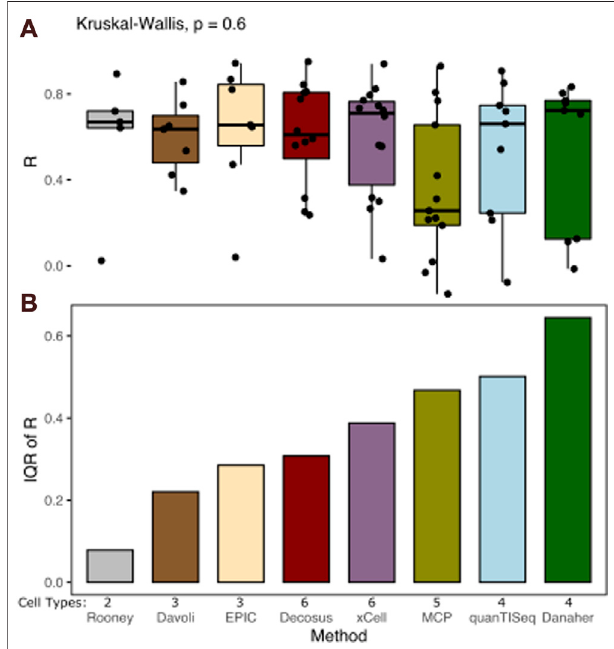
FIGURE 1 | Decosus produces stable estimates of cell proportions. (A) Box plot of the Pearson ’ s R of correlation between decomposed and simulated cell fractions ( n = 500 per single-cell RNA-Seq data used in the simulationsstudies). Thehigher the R,the moresimilarthedecomposed and simulated cell fractions are. (B) Bar plot of inter-method variability in Pearson ’ s R of correlation between decomposed and simulated cell fractions measured by IQR. The lower the IQR, the more stable the estimates from the methodacrossdatasetsandcelltypes.Withintheplots,coloursrepresentthe method of estimating cell fractions from bulk RNA-Seq datasets. The number of cell types covered for each method in the simulation is indicated (Cell Types). MCP =